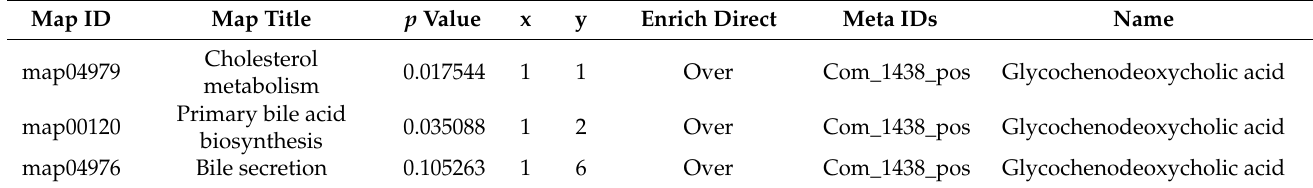
Table 3. KEGG enrichment pathway in positive mode.